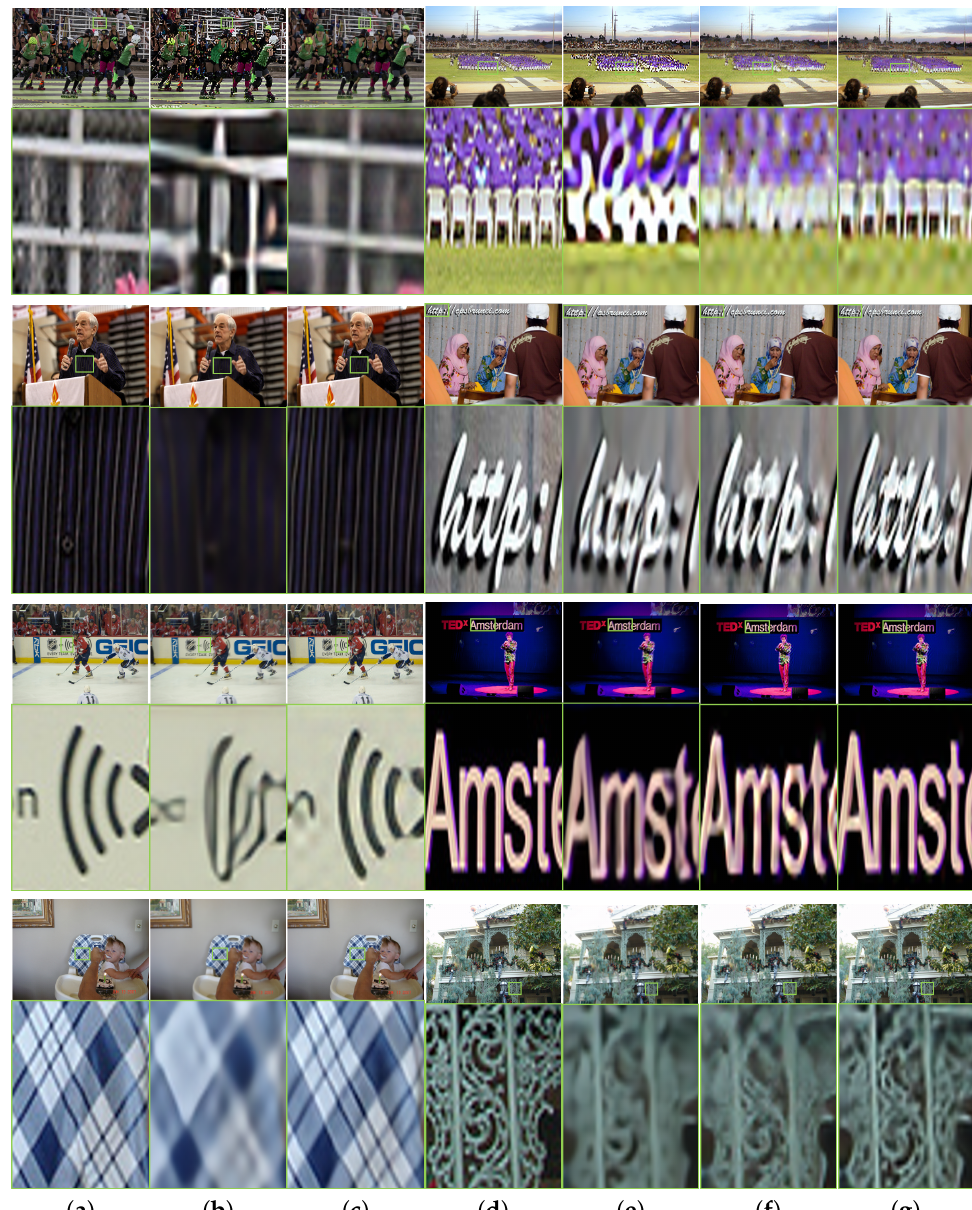
Figure 2. Qualitative comparison of RefSR methods on the non-bicubic CUFED5 datasets. From the top, each kernel ( g d , g d , g d , g b ) was used. ( a ) GT images. ( b ) RCAN [7]. ( c ) Ours + RCAN [7]. 0.2 2.0 aig 1.3 ( d ) GT images. ( e ) TTSR [21]. ( f ) Ours + TTSR [21] using D Ref 1 r . ( g ) Ours + TTSR [21] using D Ref 2 r